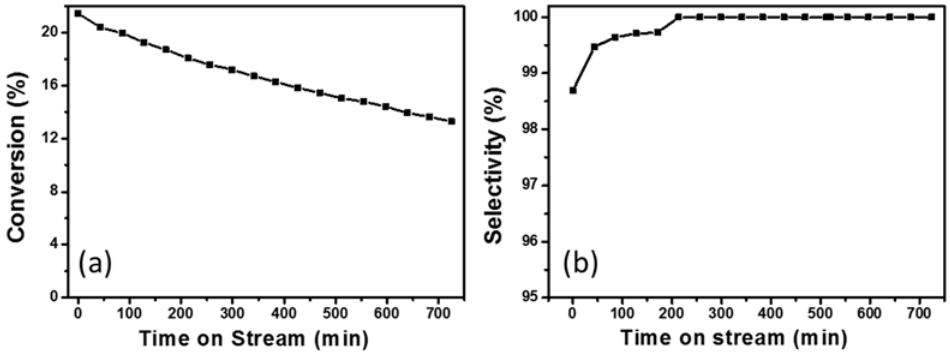
Figure 12. Stability test of PtSn/Mg(Al)O ‐ 5 during ( a ) C 2 H 6 conversion, and ( b ) C 2 H 4 selectivity.